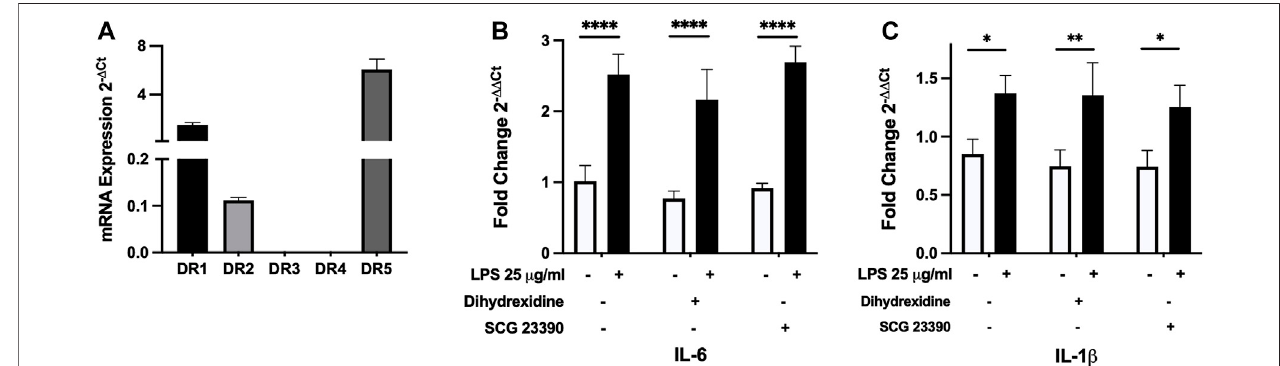
FIGURE4| SiHacellsprimarilyexpressD1-likedopaminereceptorsbutreceptor-speci fi cagonists/antagonistsdonotmodulateLPS-inducedIL-6andIL-1 β gene expression. (A) Using qRT-PCR, SiHacellswere foundtoexpressD1-like (DR1 andDR5) receptors and lowerlevels oftheD2-likereceptor (DR2). IL-6 (B) andIL-1 β (C) gene expression in control (white bars) or LPS-treated cultures (black bars) were not altered by 1 µM dihydrexidine HCl (D1-like receptor agonist) or 1 µM SCG 23390 (D1-like receptor antagonists). The analysis was done using qRT-PCR. Data presented as mean ± SD (receptor expression, n (cid:2) 3; agonist/antagonist, n (cid:2) 4). * p < 0.05, ** p < 0.01 and **** p < 0.0001.